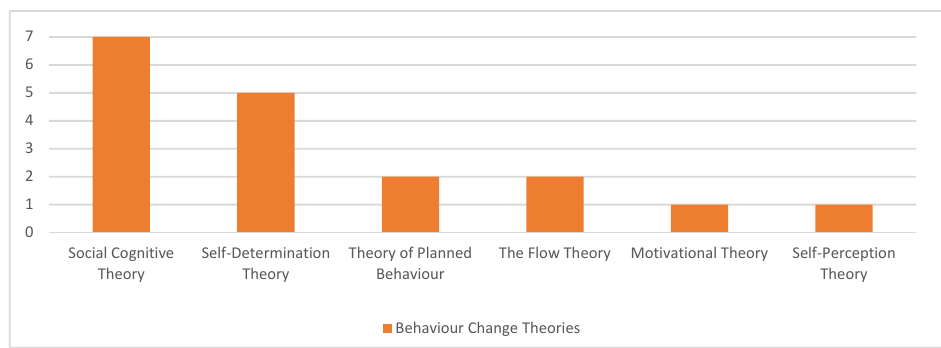
Figure 6. The frequencies of Behaviour Change theories in the Health domain.